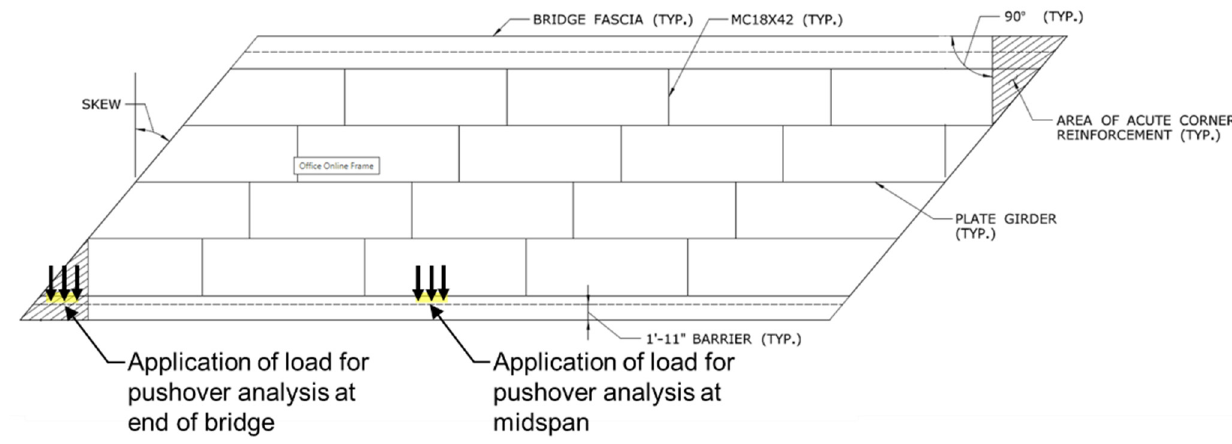
Figure 10. Locations of loading for pushover analyses of the prototype bridge models.